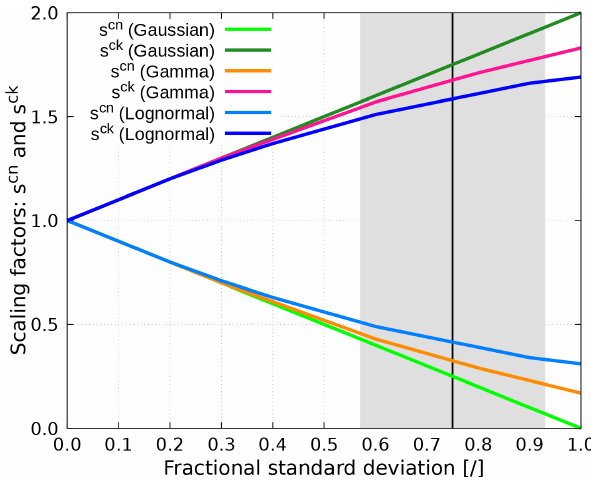
Figure 4. Scaling factors ( s cn , s ck ) of LWC for Gaussian, gamma and lognormal distributions. The black line and the gray area repre- sent mean global FSD and its